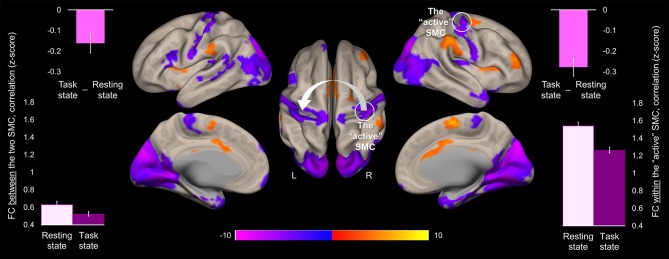
Task-induced change in the whole-brain functional connectivity of the “active” somatomotor cortex. The results of the whole-brain analysis are showing regions where FC with the hand area of the “active” SMC significantly changed during the motor sequence task comparted to the resting state ([Task state]—[Resting state]). The analysis was performed using the ROI within the “active” SMC as a seed (the white circle). The statistical map is displayed over the inflated mean cortical surface of all participants at p < 0.001 (two-tailed). A horizontal color bar represents t values with red-yellow and blue-magenta shades indicating task-induced stronger and weaker FC with the “active” SMC, respectively. L and R—left and right hemisphere, respectively. The values of the FC between the two SMC (the white arrow) and within the “active” SMC (the white circle) were extracted separately from the resting and task state time-series (lower left and right plot, respectively); the task-induced decreases in the FC strength between the two SMC and within the “active” SMC are also plotted (upper plots). Columns represent group means. Error bars represent standard errors of the mean (s.e.m.). SMC, somatomotor cortex.